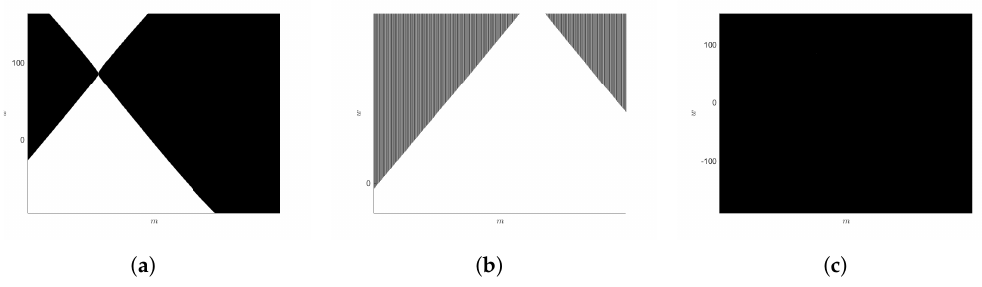
Figure 7. Training images. (a) Positive image. (b) Negative image. (c) Negative image.